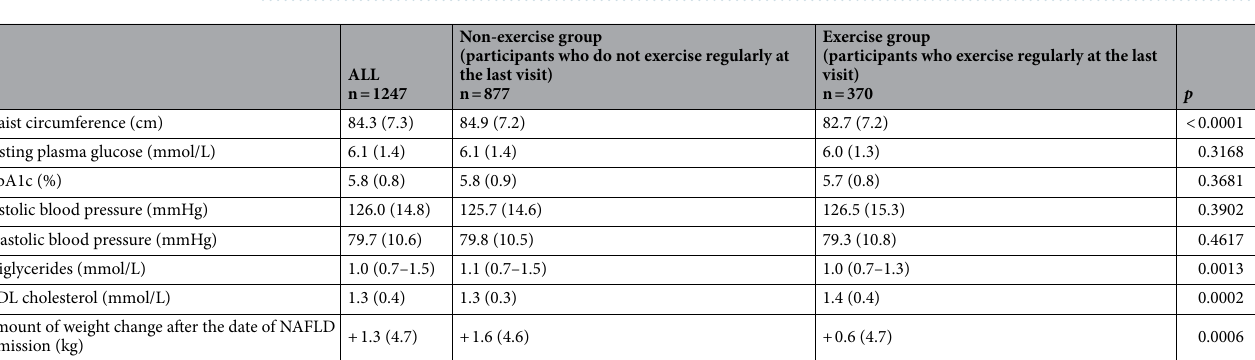
Table 3. Comparison of metabolic syndrome parameters at the last visit and amount of weight change after NAFLD remission between the non-exercise group and exercise group in men.